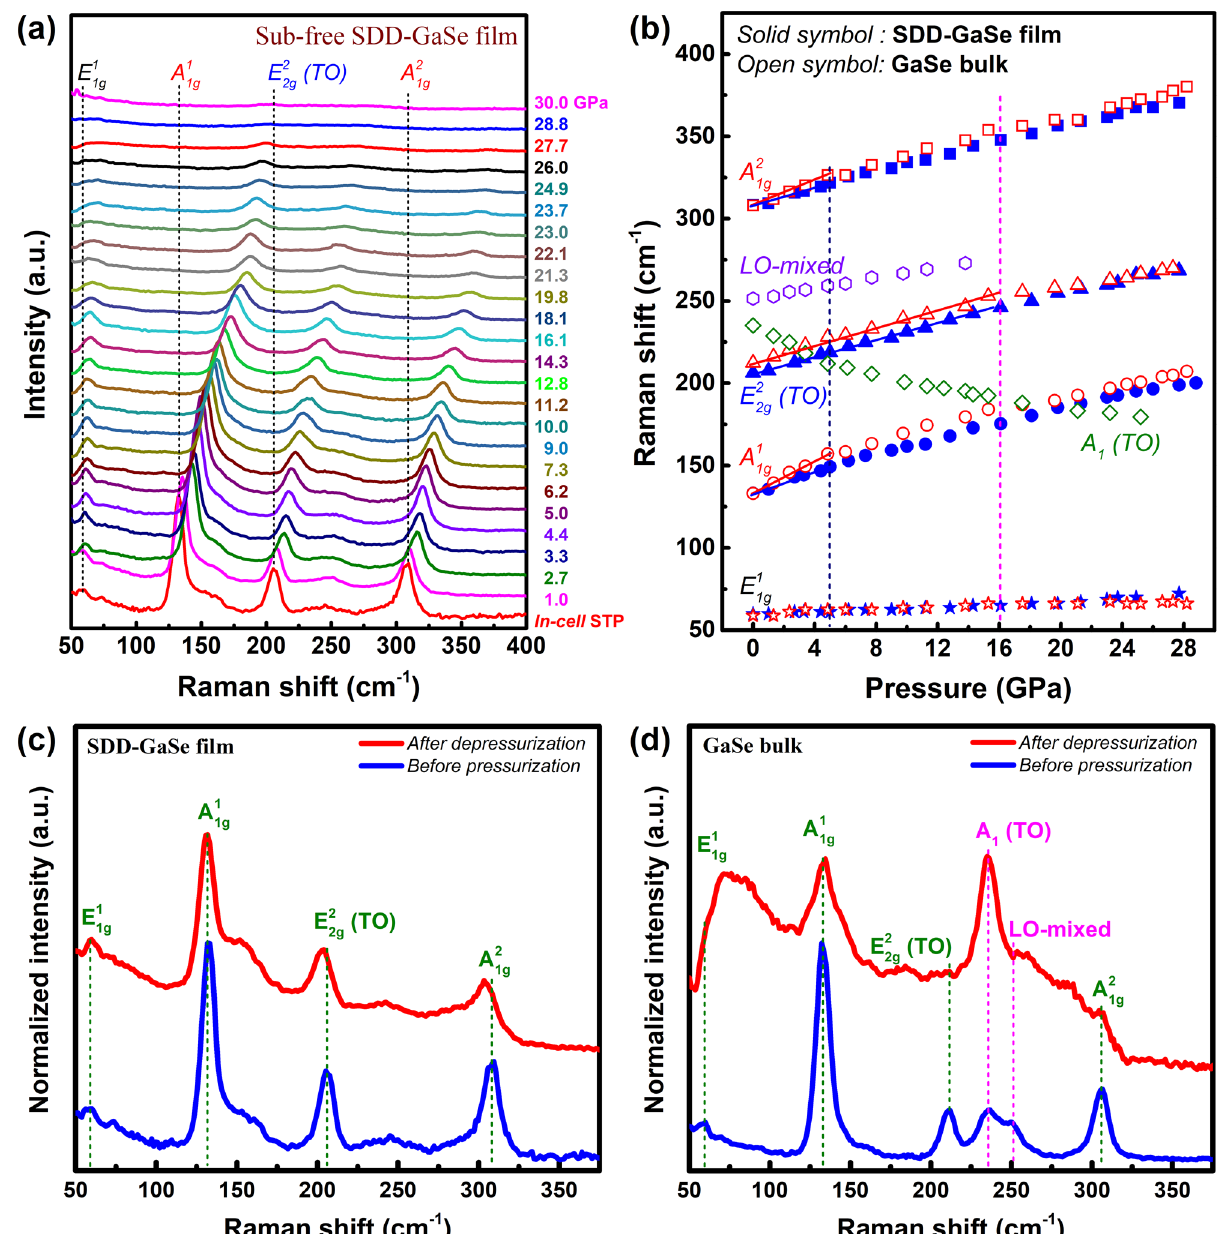
Figure 4. (a) Selected Raman spectra under 532 nm laser excitation of the sub-free SDD-GaSe film during pressurization. (b) Pressure dependence of phonon vibration modes observed from the sub-free SDD-GaSe film and the GaSe bulk. STP: standard temperature pressure at ambient. 532 nm excited Raman spectra of (c) the sub-free SDD-GaSe film and (d) the GaSe bulk before pressurization and after